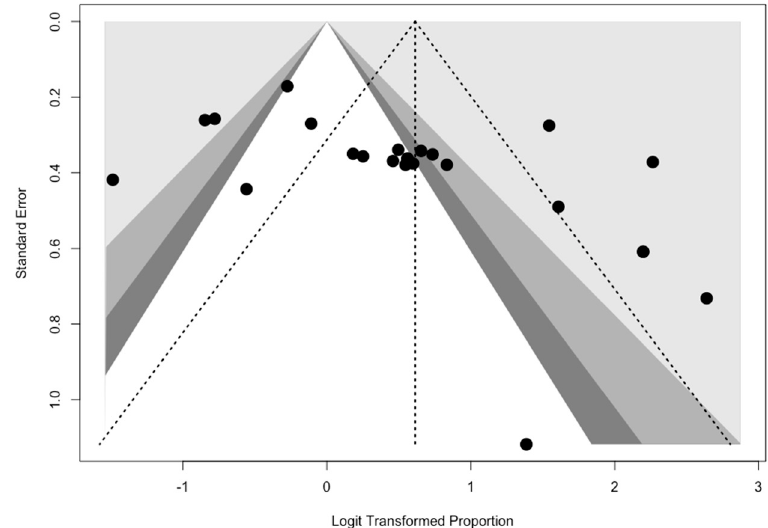
Figure A1. Funnel plot for sensitivity of studies included in the meta-analysis. Visual inspection suggested a significant asymmetry, with subsequent reporting bias.